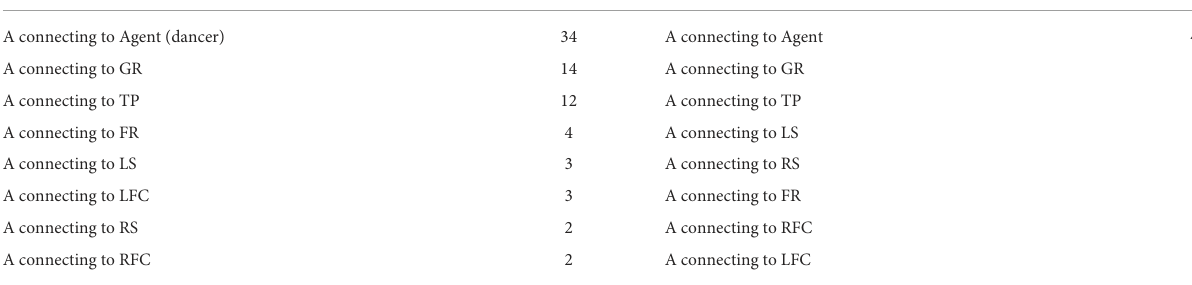
TABLE 1 Narrative projections of arms and hands.